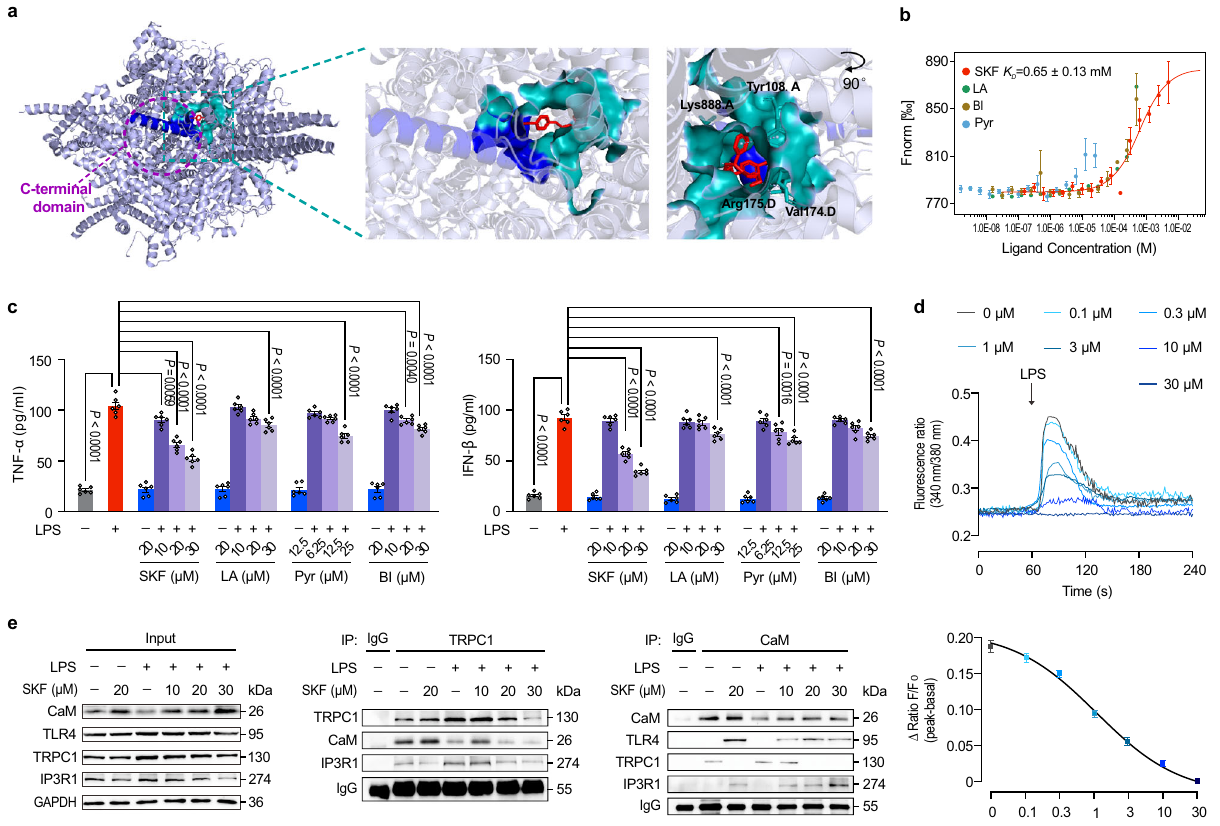
Fig. 8 | SKF96365 (SKF) blocks TRPC to obstruct the Ca 2+ release and TLR4- mediatedin fl ammationburst.a StructuralinsightsintotheSKFbindingpocketin humanTRPC6(PDBcode5YX9)anditsinteractionwiththeCIRBdomainofTRPC6. b The interaction between the C-terminal TRPC1 fusion protein and potential inhibitors, SKF, Larixyl acetate (LA), Pyr10 (Pyr), and BI-749327 (BI), measured by MSTassay(mean±SEM, n =3biologicalindependentexperiments). c Theeffectsof TRPC inhibitors on TNF- α and IFN- β productions in LPS-stimulated neonatal mice cardiomyocytes(mean±SEM, n =6samplespergroup).Statisticalsigni fi cancewas determined using the one-way ANOVA with Tukey ’ s multiple comparisons test.